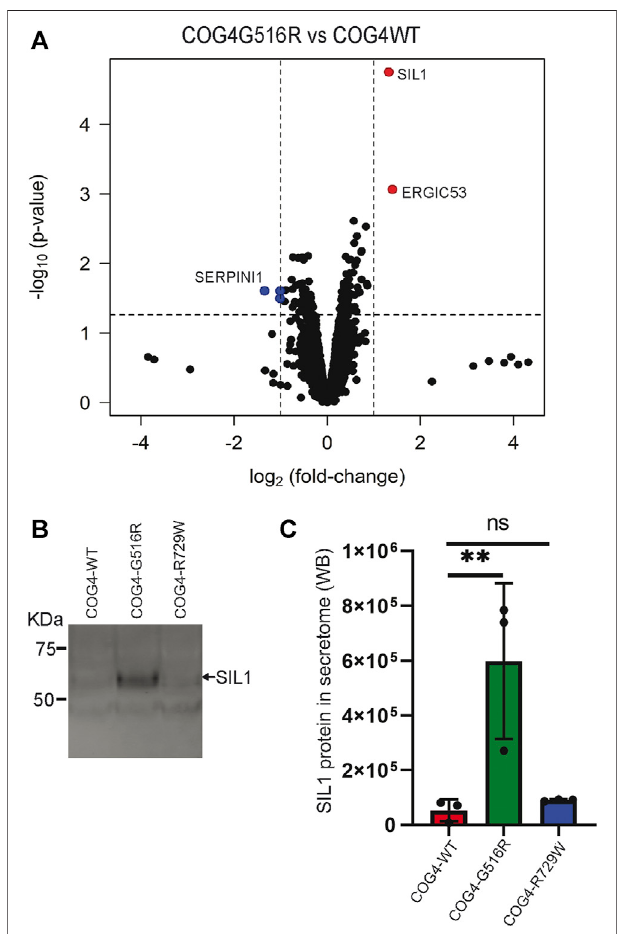
FIGURE 8 | Abnormal secretion of SIL1 and ERGIC53 from COG4- G516R mutant cell line. (A) Volcano plot obtained from quantitative mass spectrometry analysis of protein secretome from RPE1 rescued COG4-WT- 3myc and COG4-G516R-3myc cell lines (x-axis represents the log2 of the fold change, the y-axis represents the negative decade logarithm of the signi fi cance value). Red dots and blue dots represent proteins that are signi fi cantly upregulated and downregulated (B) Western blot analysis of the secretome from three rescued cell lines respectively and stained with the SIL1 antibody. (C) Quantitative analysis of secreted SIL1 protein level. Statistical signi fi cance was calculated by GraphPad Prism 8 using One-way ANOVA. ** p ≤ 0.01 and non-signi fi cant (ns) p > 0.05. Error bar represents mean ±